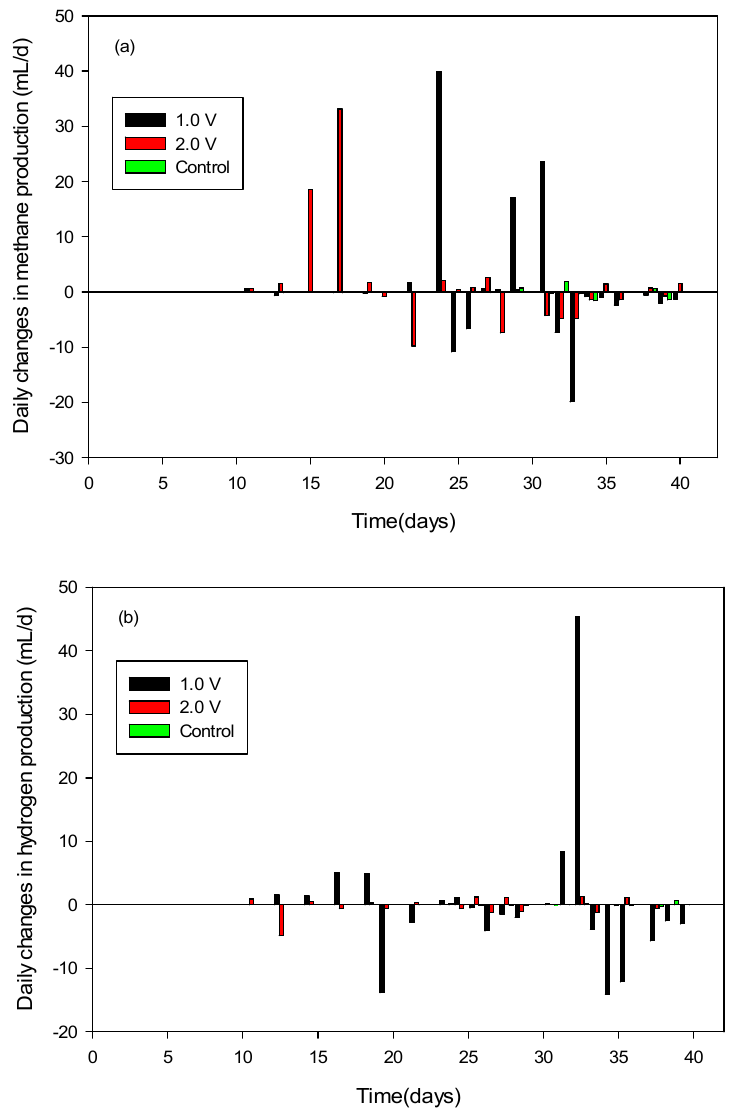
Figure 3. Daily changes in ( a ) methane production and ( b ) hydrogen production.